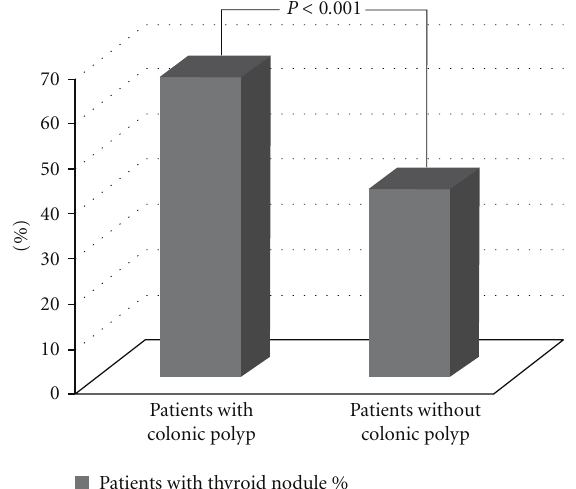
Figure 1: Percentage of patients with or without thyroid